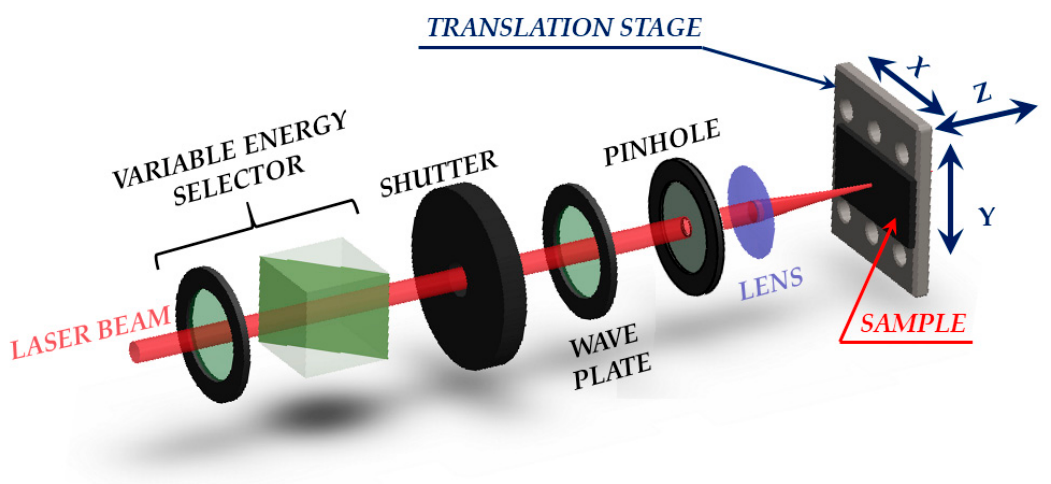
Figure 1. Sketch of a typical setup used in direct femtosecond (fs) laser surface structuring. The variable energy selector is formed by a half waveplate and a polarizer.